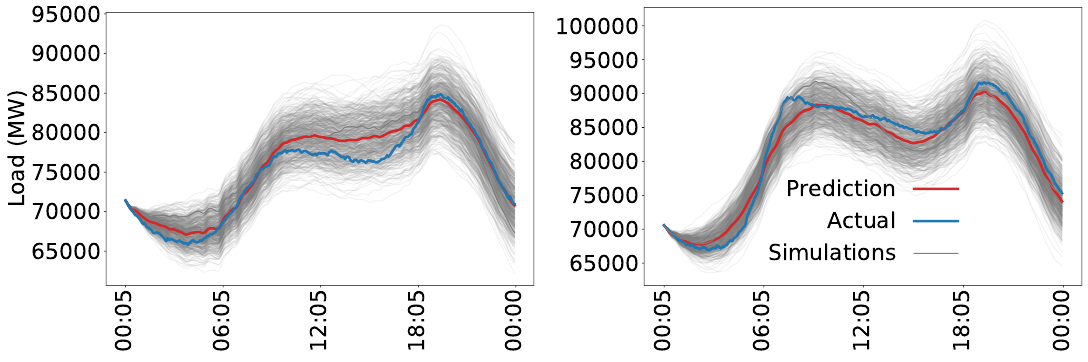
Figure 11. Load forecast examples: ( left ) 28 October 2018; and ( right ) 29 October 2018.